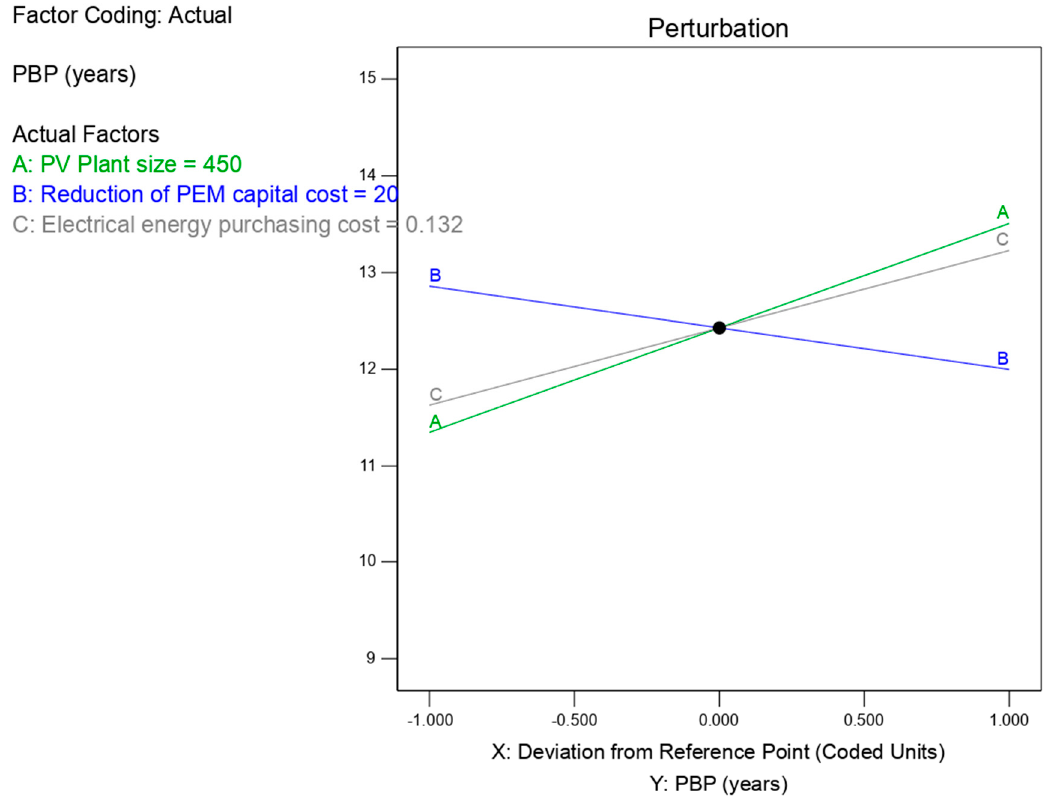
Figure 5. PBP—perturbation factors plot at the design space’s midpoint.